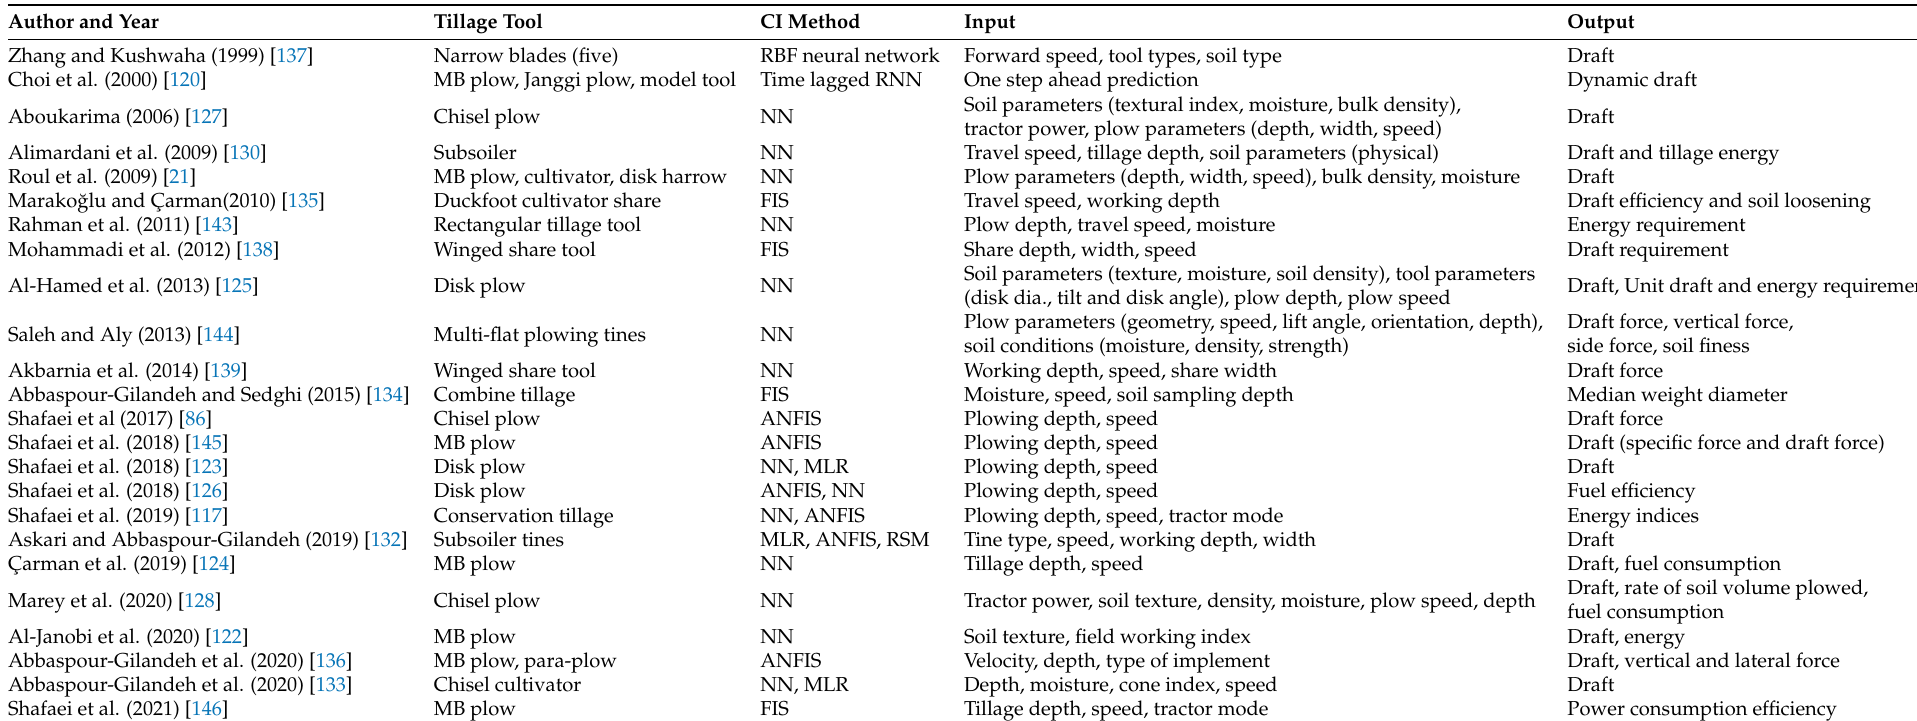
Table 2. Tillage studies that employed the CI